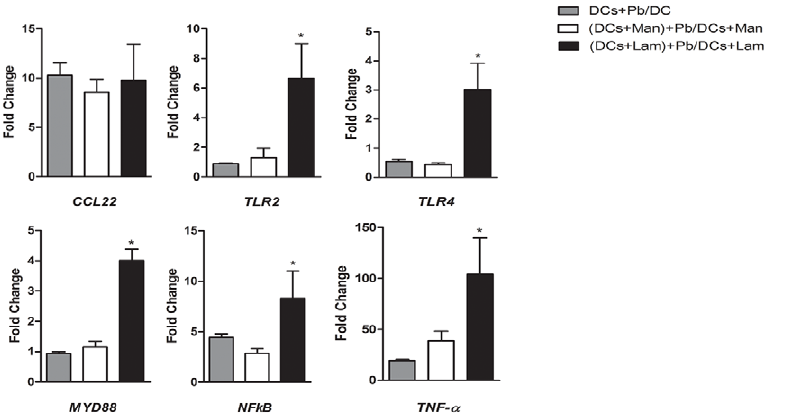
Figure 3. Effect of mannan and laminarin on the accumulation of selected immune-related transcripts in dendritic cells infected with P.brasiliensis . Murine bone marrow-derived DCs were incubated with mannan (Man) or laminarin (Lam) at 100 and 200 m g/ml, respectively, for 30 min. Subsequently, P. brasiliensis yeast cells (Pb) were added to DCs at a ratio of 1:1, and the co-culture was incubated for 6 h. Total RNA was extracted from DCs and used in qRT-PCR assays. Fold-change values were determined after each gene was normalized to RPS9 using the comparative threshold method. Data are reported as the mean 6 standard deviation. * P , 0.05 compared to the DCs + Pb/DCs group.